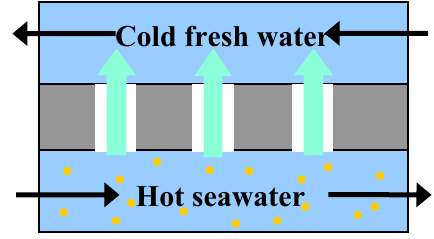
Figure 9. Principle behind direct contact membrane